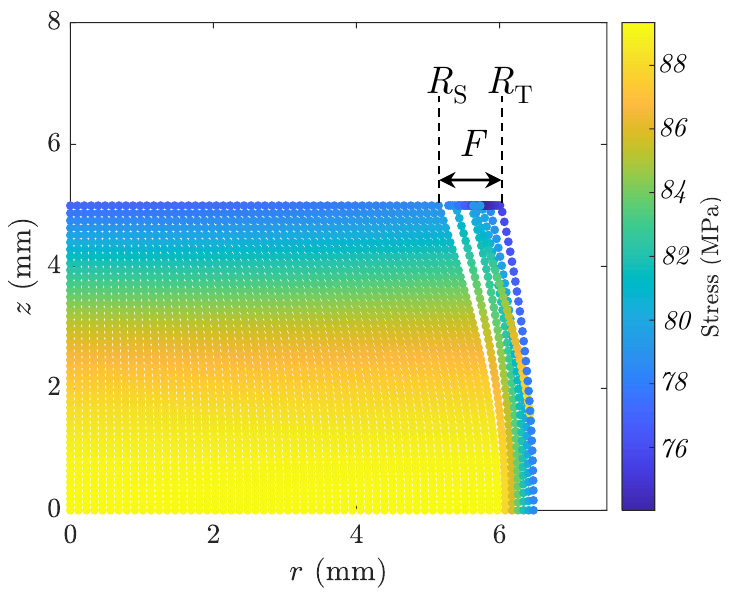
Figure 9. Discretized sample of Case 2 with a grid of 50 at the final stage of the